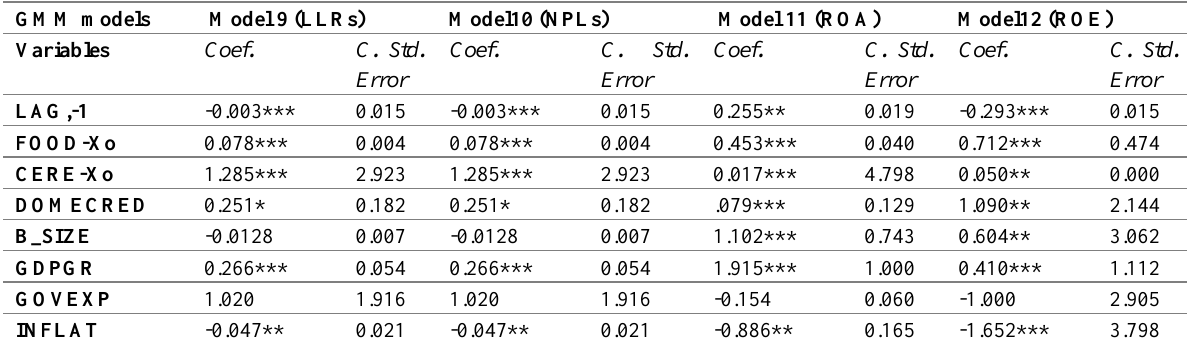
Table 7: Presents Gmm Results for Bank Risk And Profitability (Short-Run